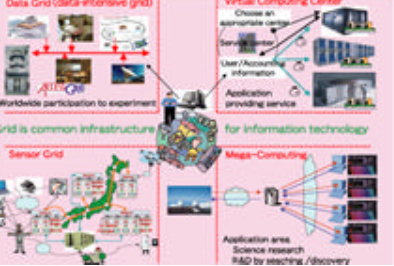
Figure 1: The Grid is common infrastructure for information